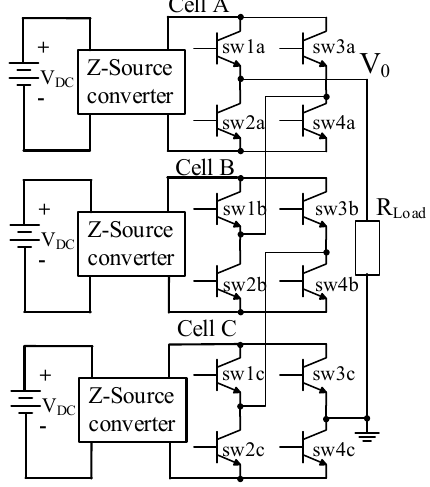
Figure 8. Combination of cascade multilevel inverters (CMLI) with the Z-source converter, used for reconfiguration purposes.